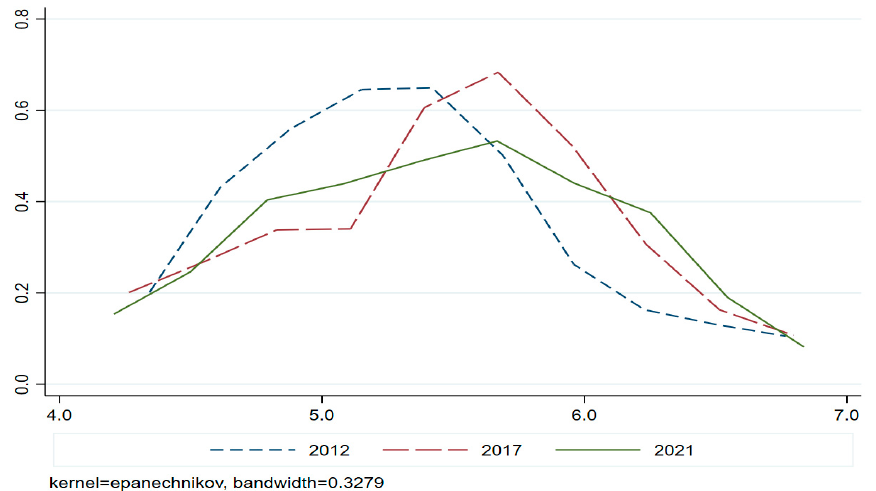
Figure 3. Kernel density map of the international competitiveness of wood-based panels in the countries observed.